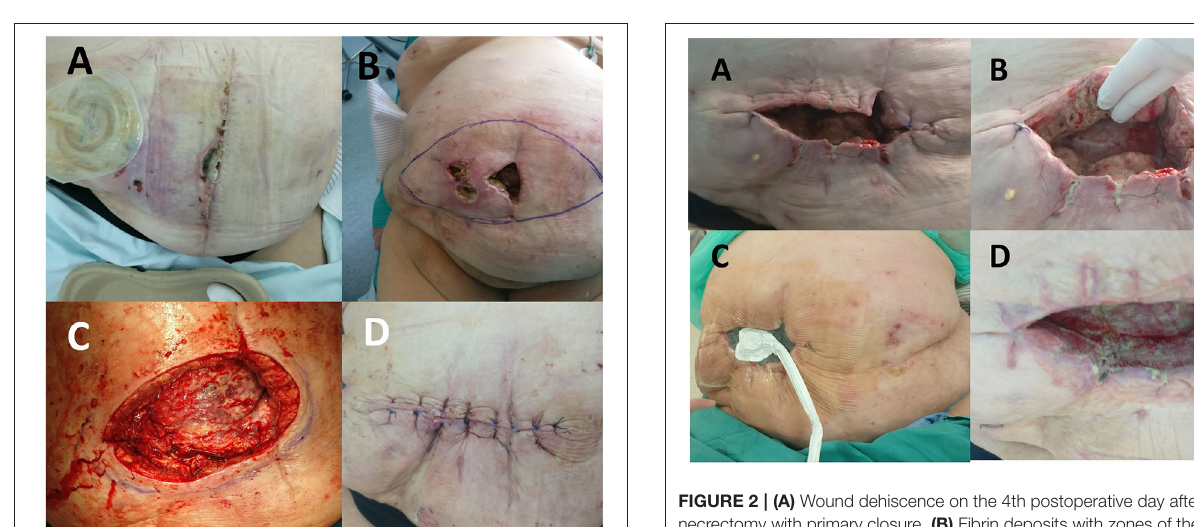
semilunar line, extending from the costal arch to the groin. This